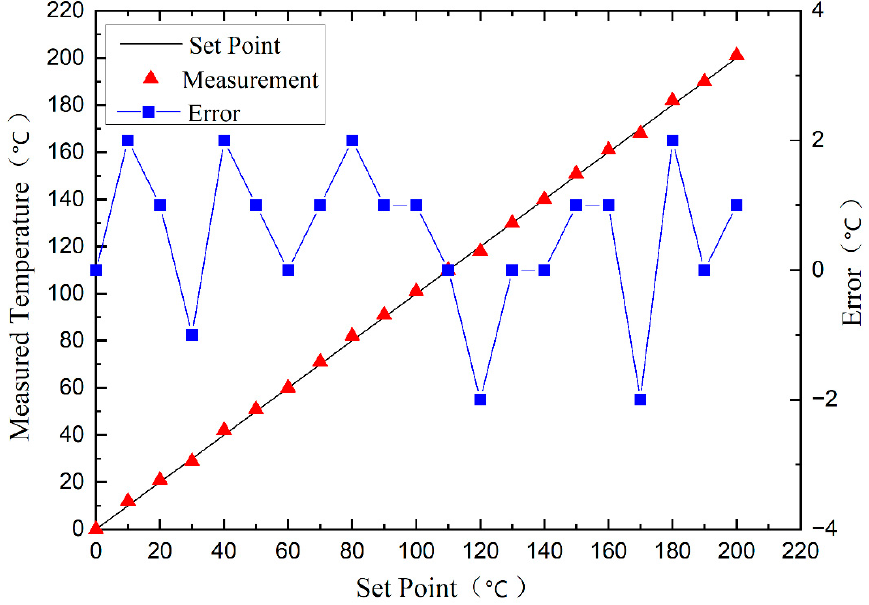
Figure 13. The testing result of the thermocouple-acquiring circuit. After precision testing, the constant temperature control system was put into practice without Cs injection. The temperature curve of the injection pipeline is shown in Figure 14. It takes 30 s to increase from 10 ◦ C to 100 ◦ C, and the target temperature is set as 100 ◦ C. The temperature fluctuation range around the set value is < ± 3 ◦ C, which completely meets the experimental demands. The temperature data can be displayed in LCD in local mode and can also be independently transmitted to a host